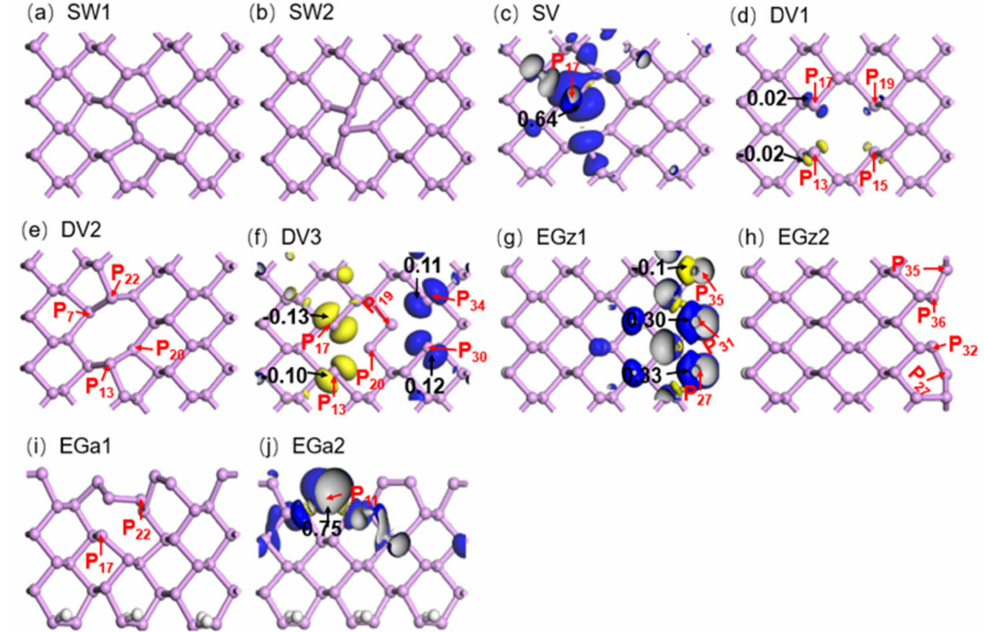
Figure 3. Spin density distribution on d − SLBP. ( a ) SW1, ( b ) SW2, ( c ) SV, ( d ) DV1, ( e ) DV2, ( f ) DV3, ( g ) EGz1, ( h ) EGz2, ( i ) EGa1 and ( j ) EGa2. Blue and yellow isosurfaces mean non − zero positive and negative spin density, respectively. Black numbers: spin population. Red numbers: Labels of phosphorus